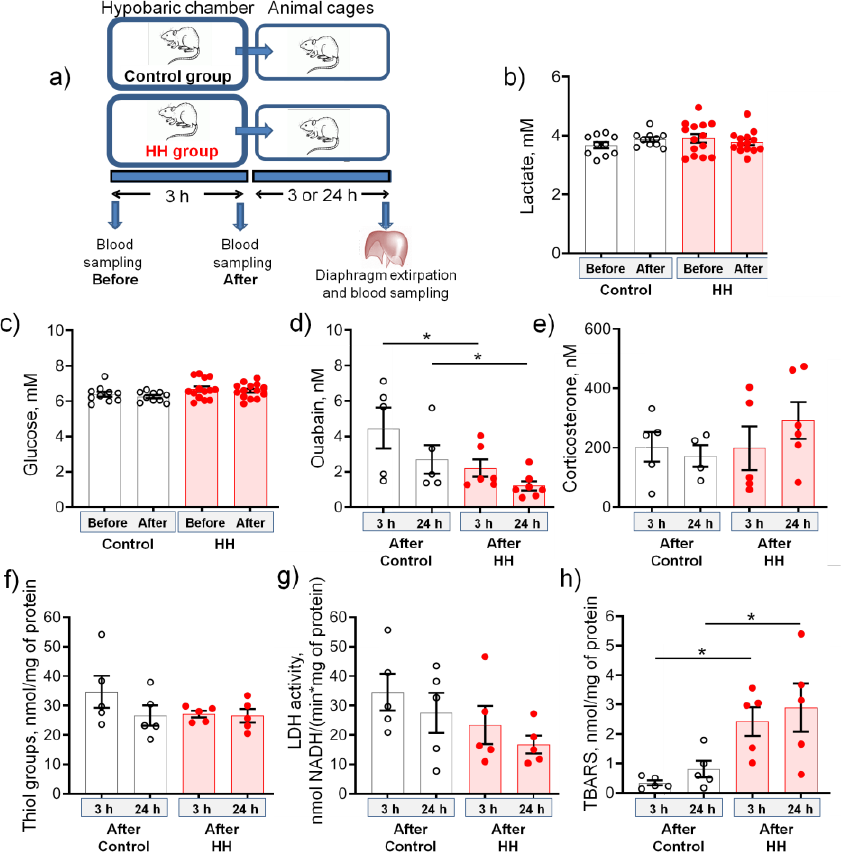
Figure 1. Biochemical responses to hypobaric hypoxia (HH) for 3 h at a pressure equivalent to an altitude of 3000 m. ( a ) The study outline. ( b , c ) Blood lactate and glucose concentrations measured immediately before and after control or HH treatment. ( d , e ) Concentrations of ouabain and corticosterone measured in the blood serum 3 or 24 h after control or HH treatment. ( f ) The concentration of thiol groups, ( g ) lactate dehydrogenase (LDH) activity, and ( h ) thiobarbituric acid reactive substances (TBARS) concentration measured in homogenate of the diaphragm muscle 3 or 24 h after control or HH treatment. The number of rats corresponds to the number of symbols. In these experiments, two groups of 10 – 14 rats of each category (control and HH, respectively) were in the pressure chamber for 3 h, and their characteristics are provided in b and c . Then, the rats from each of these categories were divided into two groups (5 – 7 rats), which were kept in cages for 3 or 24 h for further analysis ( d – h ). Two-way ANOVA followed by Bonferroni multiple comparisons test. * p < 0.05 — compared to the corresponding control.